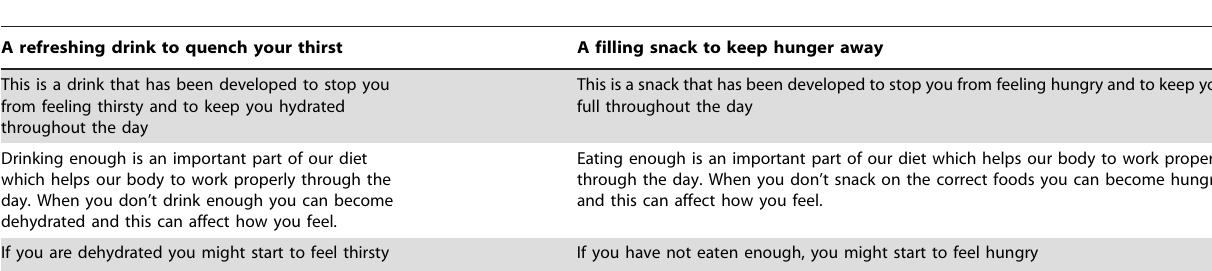
Table 2. A description of the information provided to participants in the thin/thirst-quenching and thin/filling beverage context groups.